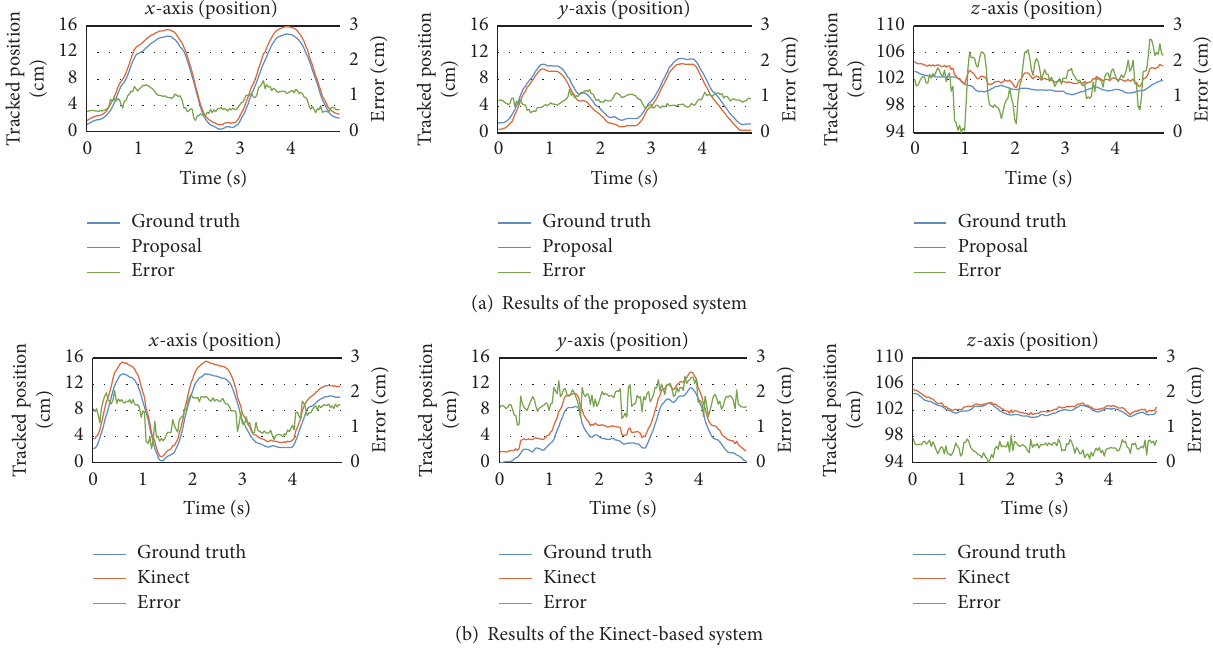
Figure 11: Tracked trajectories